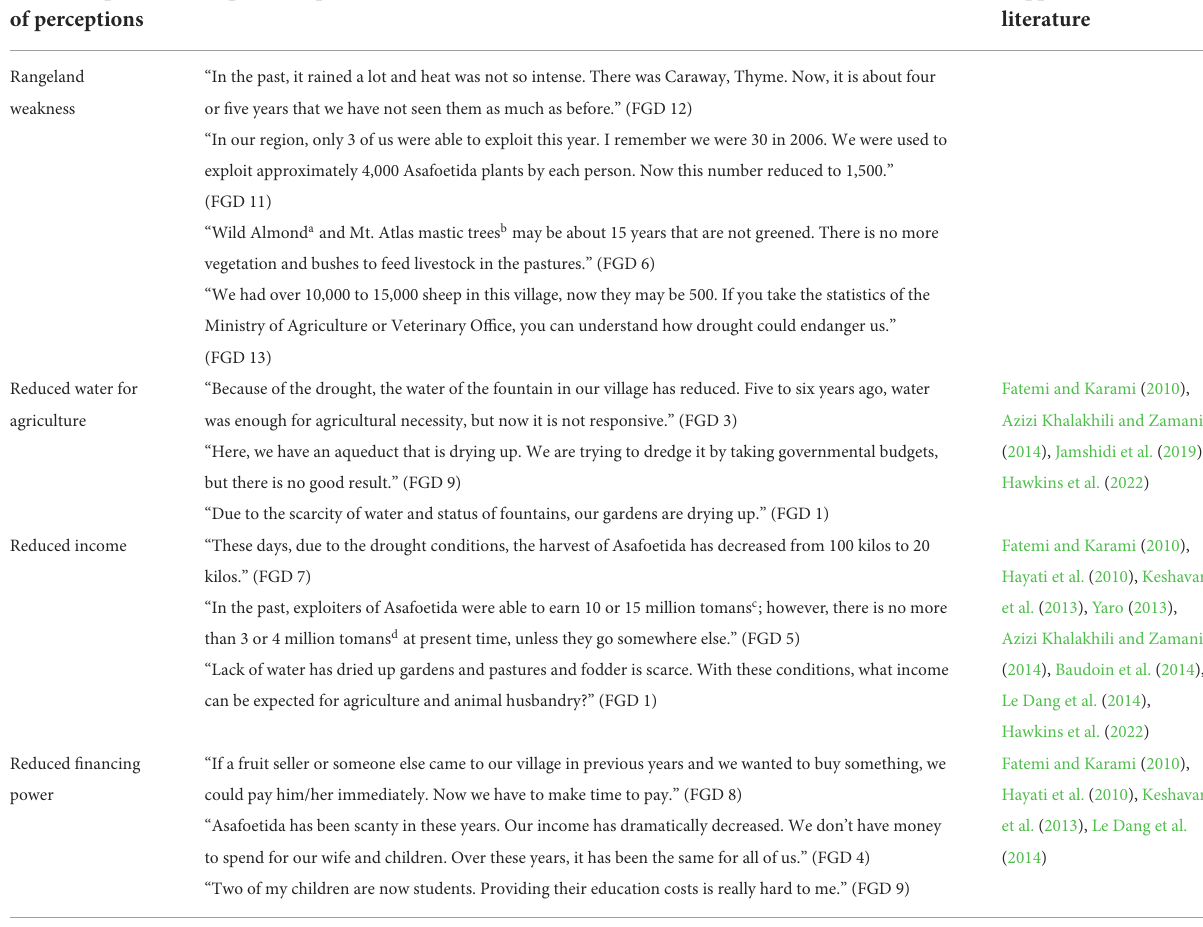
TABLE 2 Medicinal plant exploiters’ perceptions about environmental–economic